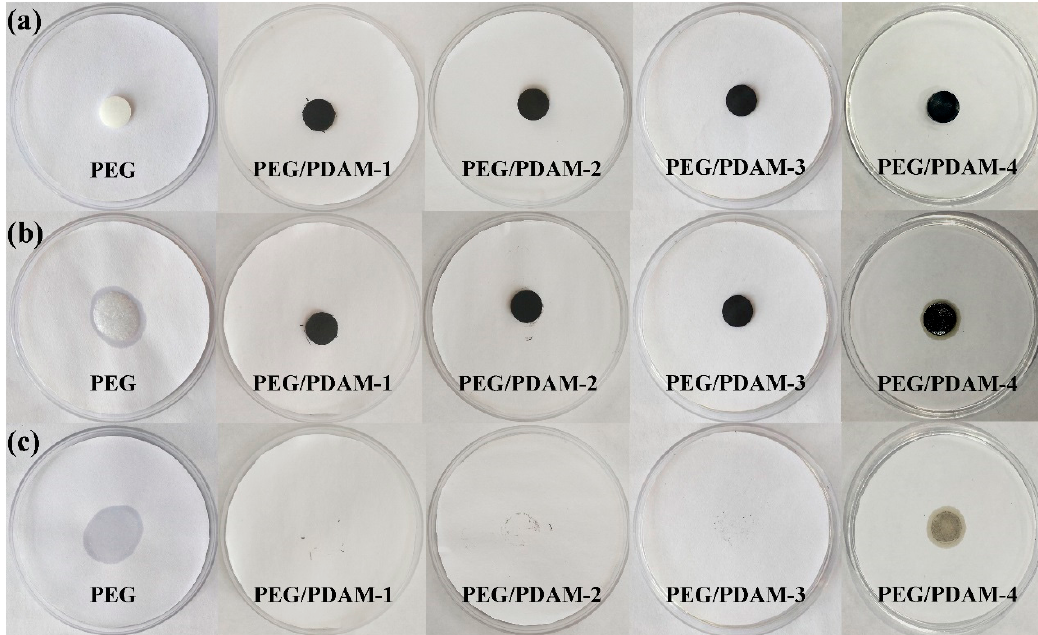
Figure 4. Leakage test photographs of PEG, PEG/PDAM-1, PEG/PDAM-2, PEG/PDAM-3, and PEG/PDAM-4.: ( a ) pictures of samples before the thermal stability test; ( b ) pictures of samples after the thermal stability test; ( c ) pictures of leakage trace after the removal of samples.